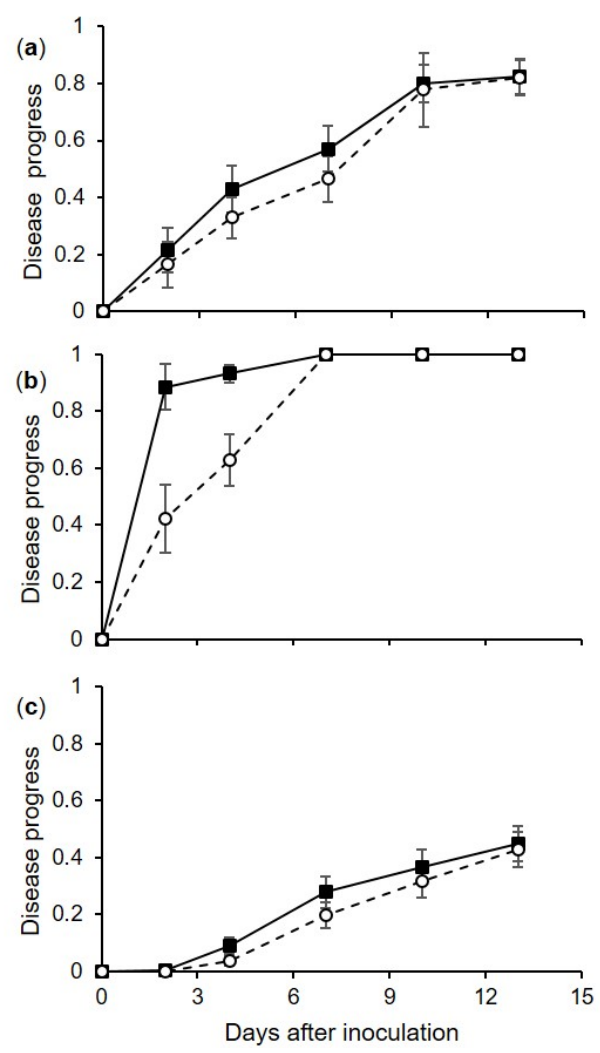
Figure 1. Progress of disease incidence (as the proportion of berries showing symptoms, on a 0–1 scale, where 1 means all of the berries are affected; black squares) and severity (as the proportion of the berry surface showing symptoms, on a 0–1 scale, where 1 means all of the berry surface is affected; white circles) on grapevine berries inoculated with conidia of Coniella diplodiella (experiment 1). After uninjured berries ( a ), injured berries ( b ), or pedicels of uninjured berries ( c ) were inoculated, the berries were kept at 30 combinations of 6 temperatures (T: 10, 15, 20, 25, 30, and 35 ◦ C) and 5 wetness duration periods (WD; 1, 3, 7, 12, and 24 h); each combination was represented by 3 replicates, with 15 berries per replicate. In each panel, values are means ( ± SE, n = 90) of disease incidence or severity with the 6 temperatures and 5 wetness duration periods.